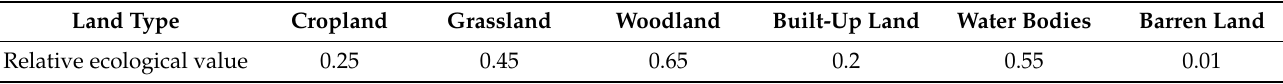
Table 2. Relative ecological values of different types land-cover types.